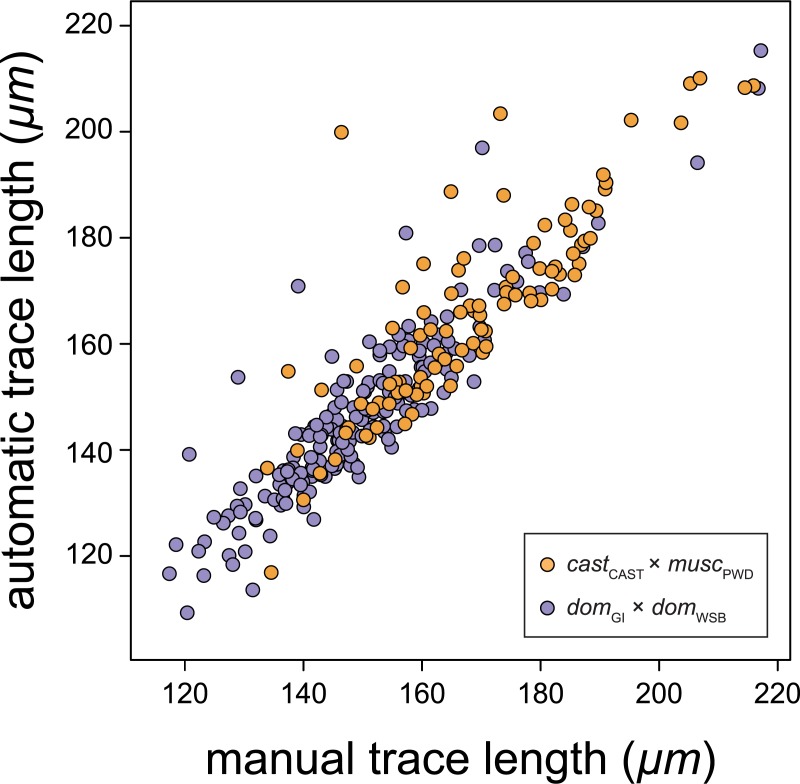
SC lengths from automated versus manual analysis.Each point represents the SC length from a single spermatocyte image in the test set. SC lengths of spermatocytes from domGI × domWSB F2 individuals are shown in purple (coefficient of determination, R2 = 0.74); those from castCAST × muscPWD F2 individuals are shown in orange (R2 = 0.81).